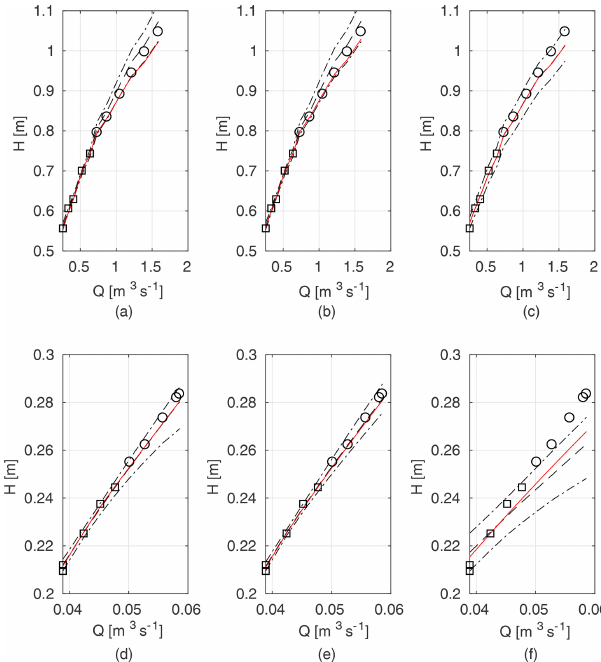
Figure 4. Ritobacken channel cross section (a) and a photograph, autumn 2011 (b) . Figure 5. Exemplary rating curves for m = 5, Ritobacken case